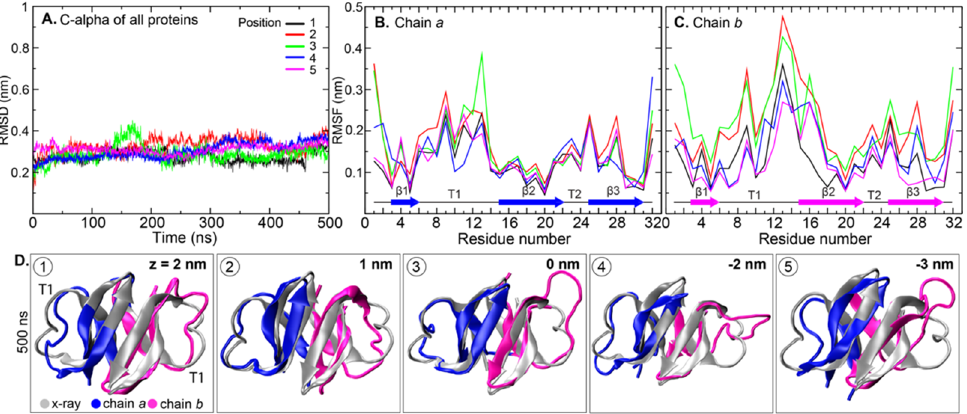
Figure 3. ( A ) C α RMSDs of HD5 protein, ( B ) C α RMSF of chain a, and ( C ) C α RMSF of chain b. RMSD and RMSF were computed using the structure at t = 0 ns as the reference. ( D ) Superimposition of each snapshot at 500 ns and X-ray structure of HD5 (PDB ID: 1ZMP).